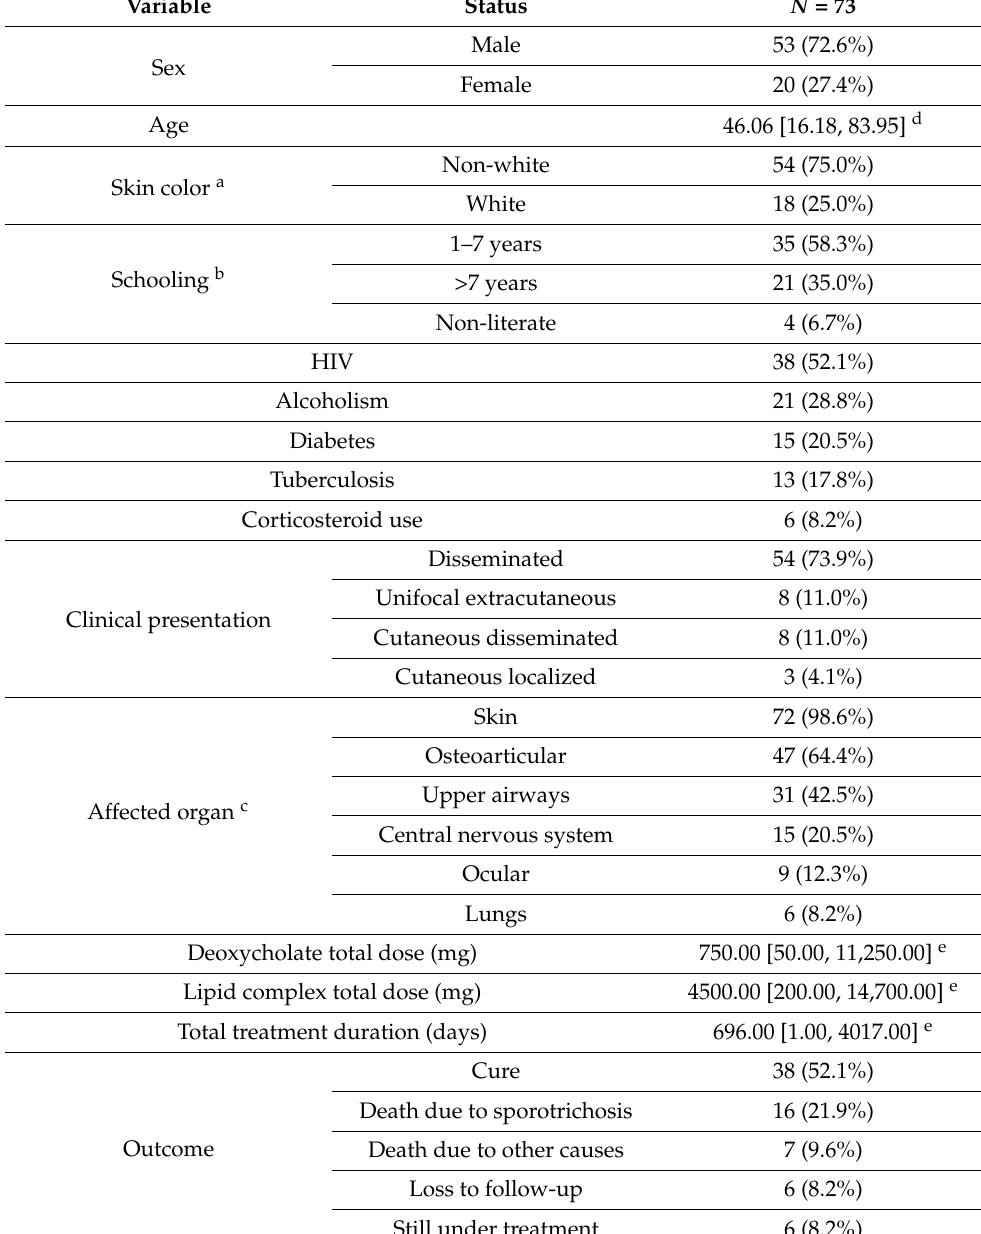
Table 1. Clinical and epidemiological data of 73 patients with sporotrichosis treated with ampho- tericin B at the INI/FIOCRUZ, Rio de Janeiro, Brazil, between 1998 and